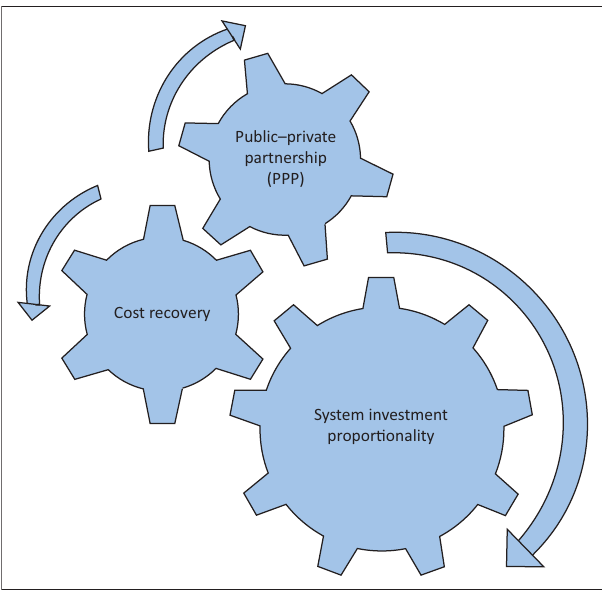
FIG URE 2: New model of economic resilience for water supply systems in